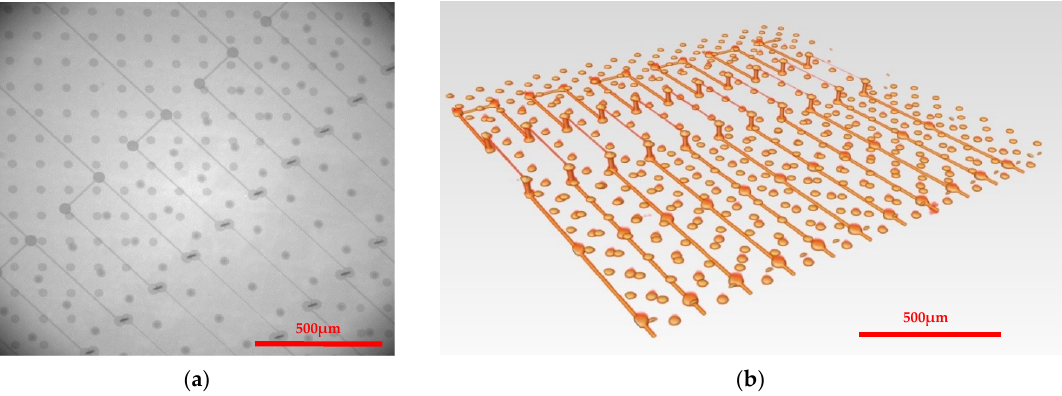
Figure 11. X-ray image under the overall scan: ( a ) 2D X-ray projection image; ( b ) 3D X-ray reconstruction image.